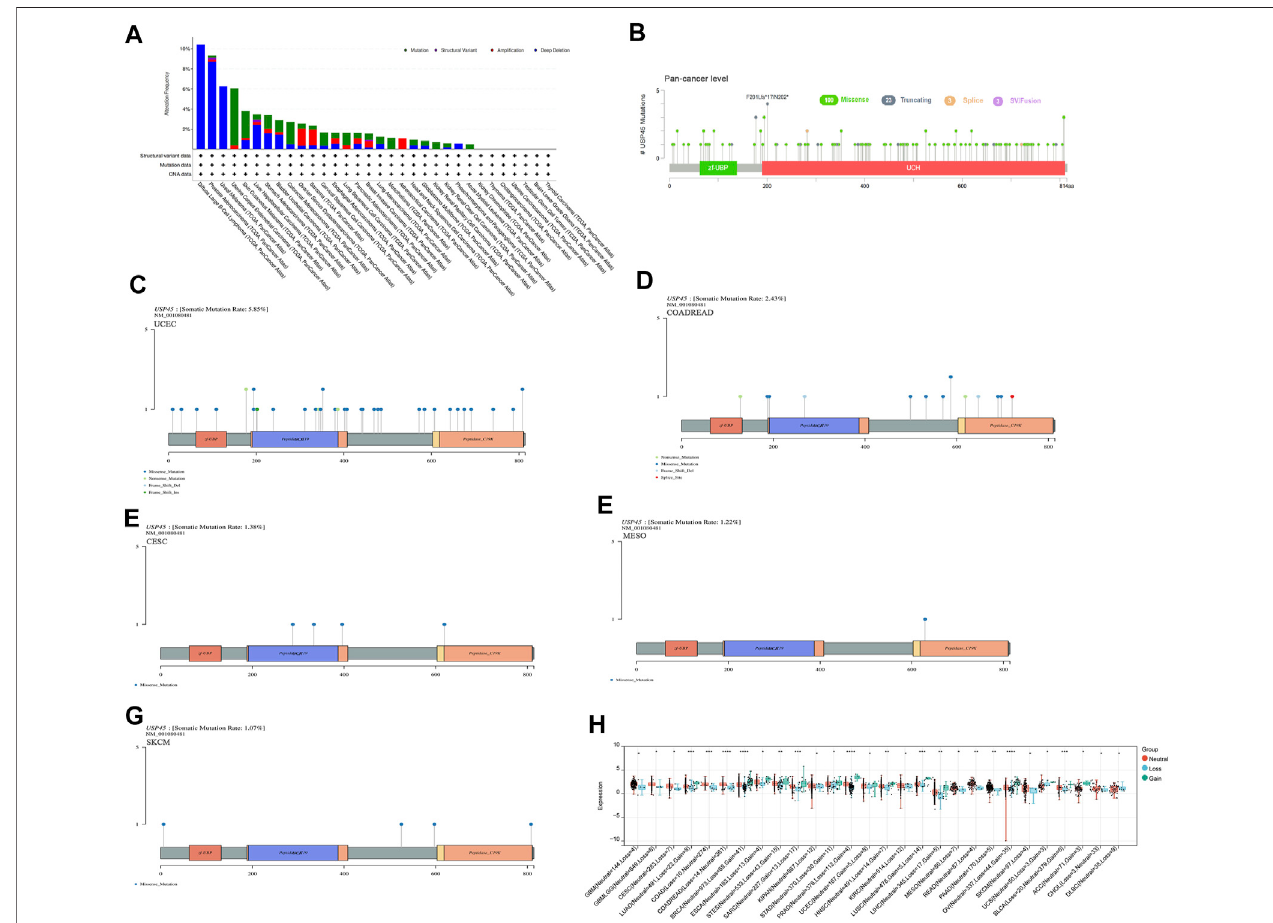
FIGURE 3 | Structural variation, gene mutation and gene copy number variation of USP45 in different types of tumors. (A) Structural variation, gene mutation and gene copy number variation of USP45 in different types of tumors were analyzed based on the TCGA database. Somatic mutation rate and mutation type of USP45 at pan-cancerlevel (B) andUCEC (C) ,COADREAD (D) ,CESC (E) ,MESO (F) ,SKCM (G) wereanalyzedandshowninthe fi gures. (H) Thedetailedinformationofgenecopy number alteration of USP45 in different types of tumors were analyzed and shown in the fi gure. * p < 0.05, ** p < 0.01, *** p < 0.001, **** p < 0.0001.